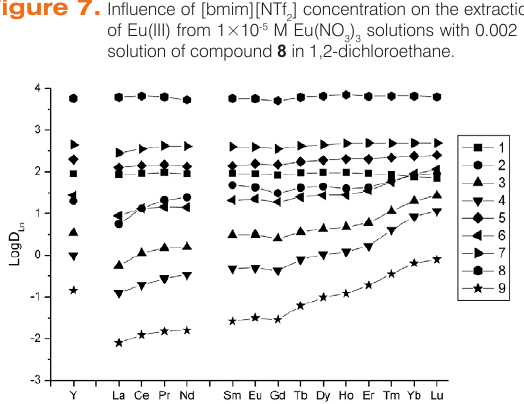
] concentration on the extraction 2 ) solutions with 0.002 M 3 3